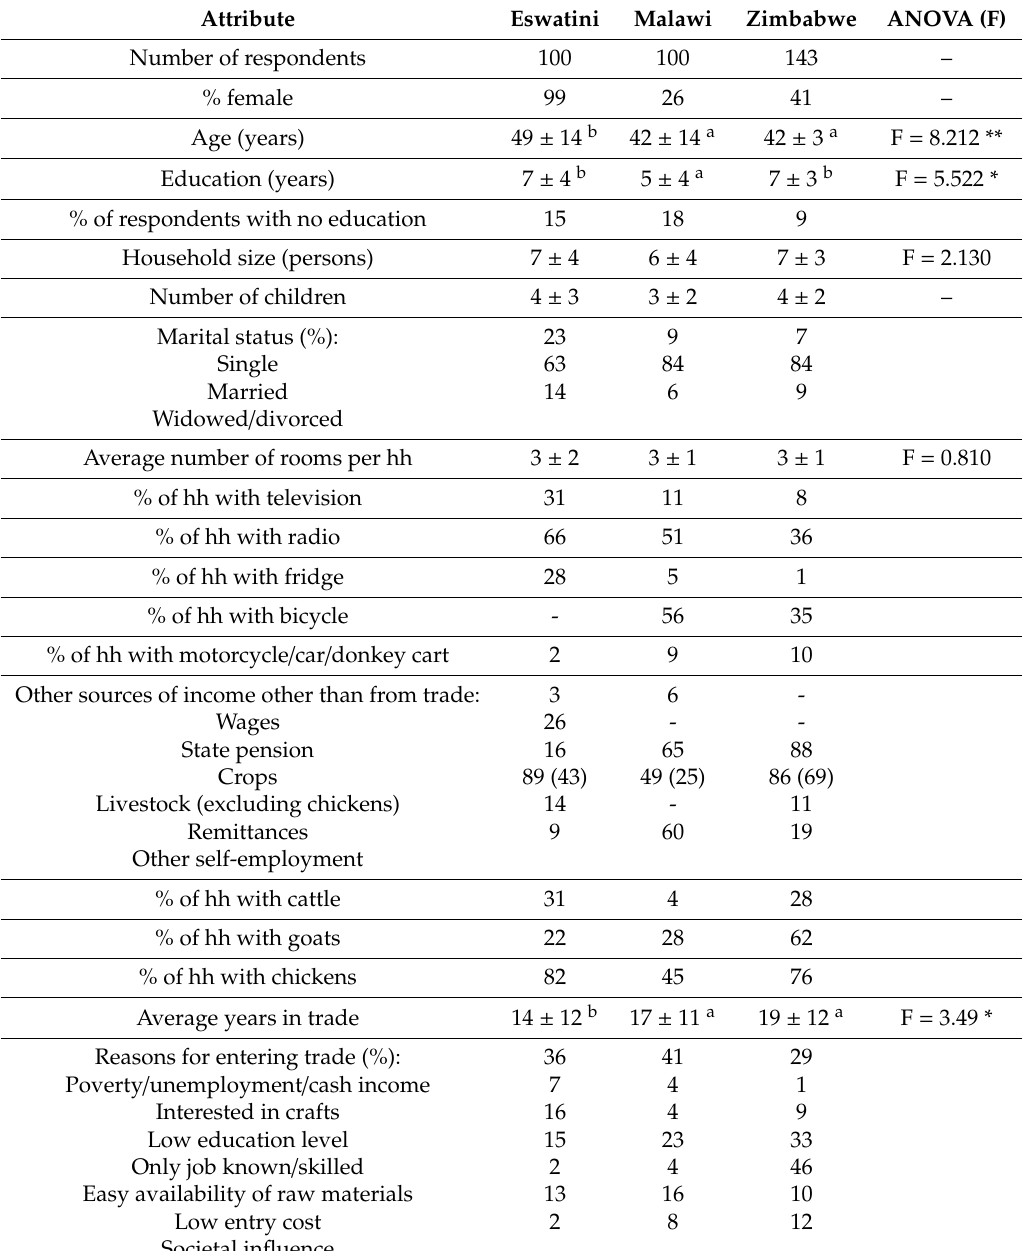
Table 2. The respondent and household (hh) socioeconomic profile of the sampled populations in the three